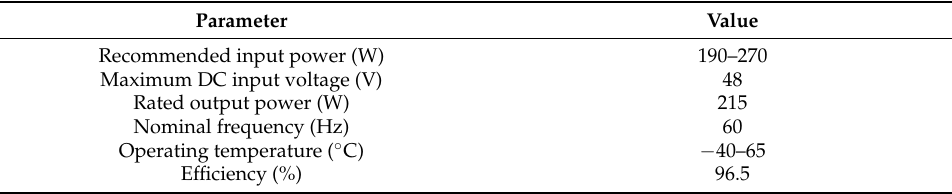
Table 2. Technical specifications for the M215-60-2LL-S micro-inverter.